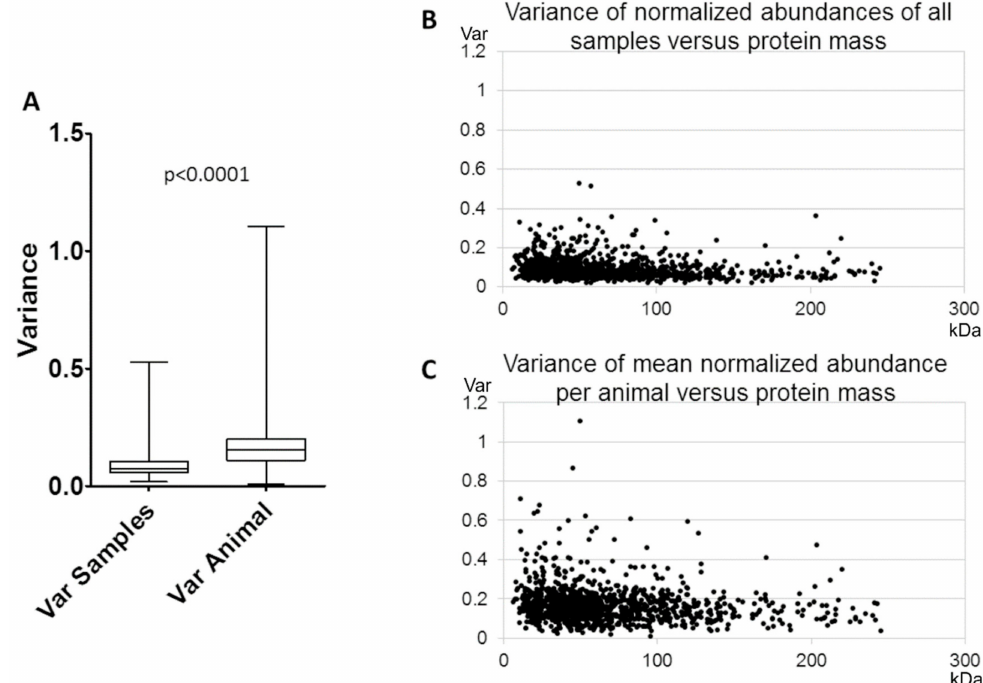
Figure 5. Variance of normalized protein abundance in single acute slices. ( A ) For each identified protein, the variance of normalized abundances for all samples was calculated (Var Samples) as well as the variance of the mean protein abundances per animal (Var Animal). ( B ) The variances of normalized abundances of all samples were plotted against the weight of the respective protein. No correlation was found (r = − 0.14744). ( C ) The variances of the mean normalized abundances per animal were plotted against the weight of the respective protein. No correlation was found (r =